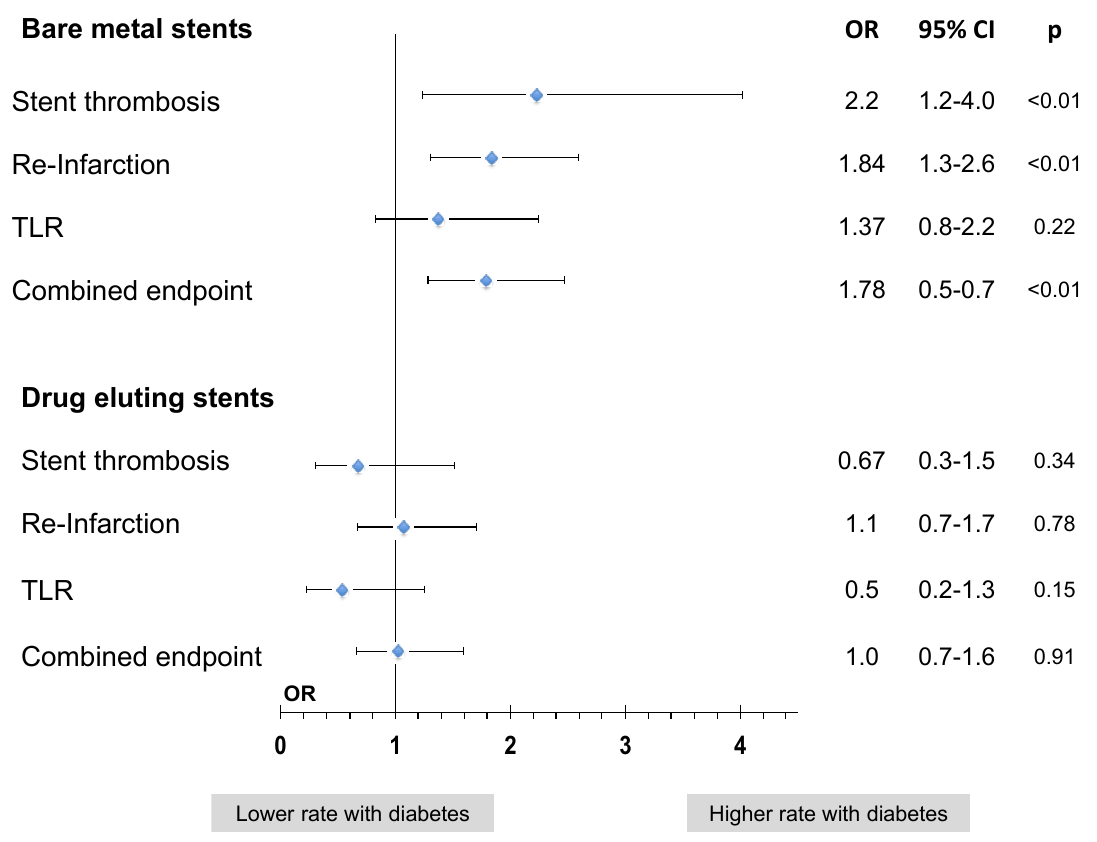
Figure 4. Impact of diabetes on ischemic event rates stratified by stent type: Comparison of adverse ischemic event rates in diabetic vs. non-diabetic patients in patients treated with BMS and DES. Multivariate model with diabetes adjusted for age, gender, cardiogenic shock, anterior STEMI, type and duration of P2Y12-inhibitor and number of stents implanted. Combined endpoint = ST + AMI + TLR.